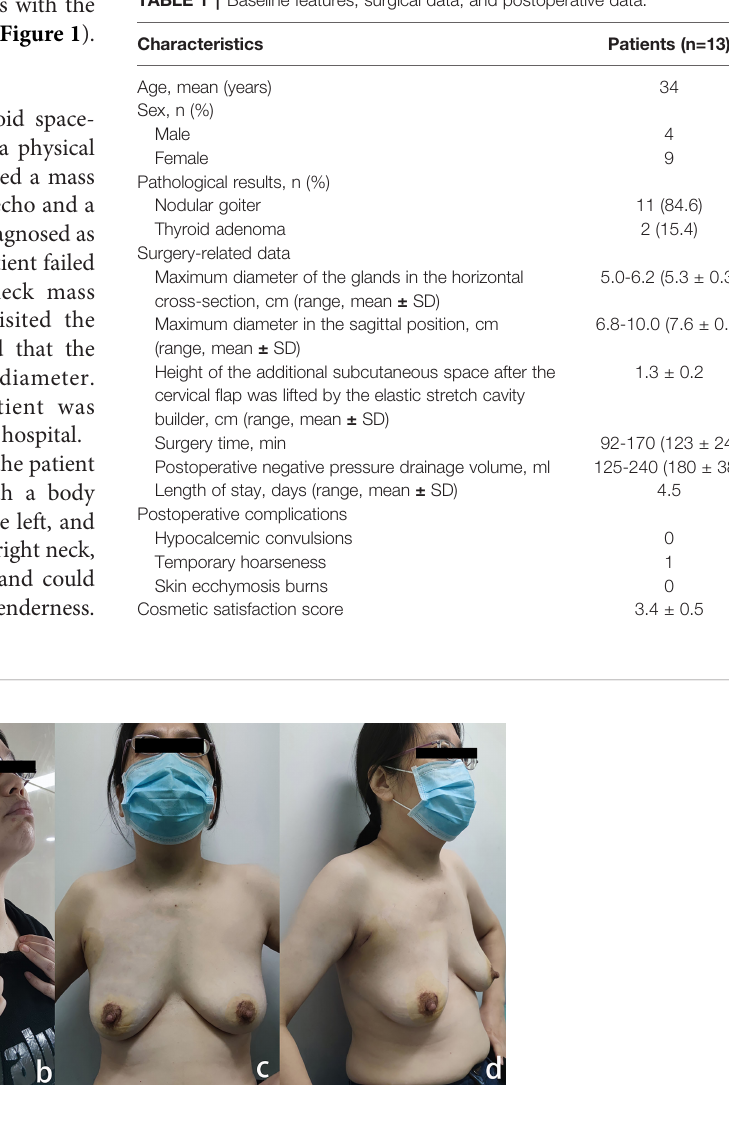
FIGURE 1 | (A) Patients ’ preoperative frontal appearance; (B) patients ’ preoperative lateral appearance; (C) The front appearance of the patients at the removal 1 week after operation; (D) the side appearance of the